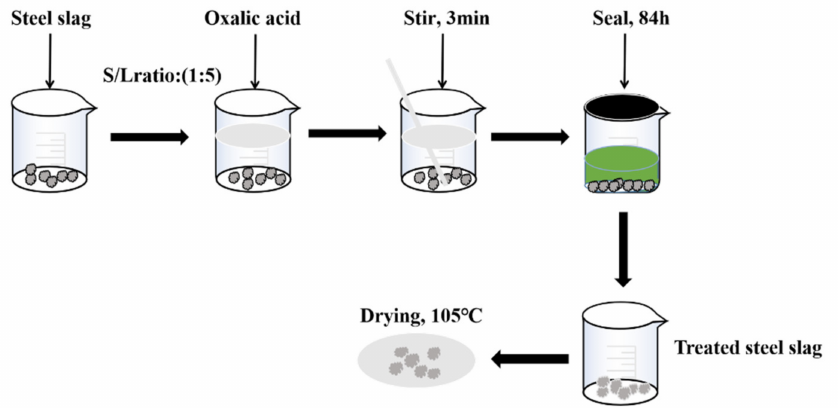
Figure 1. Treatment process of steel